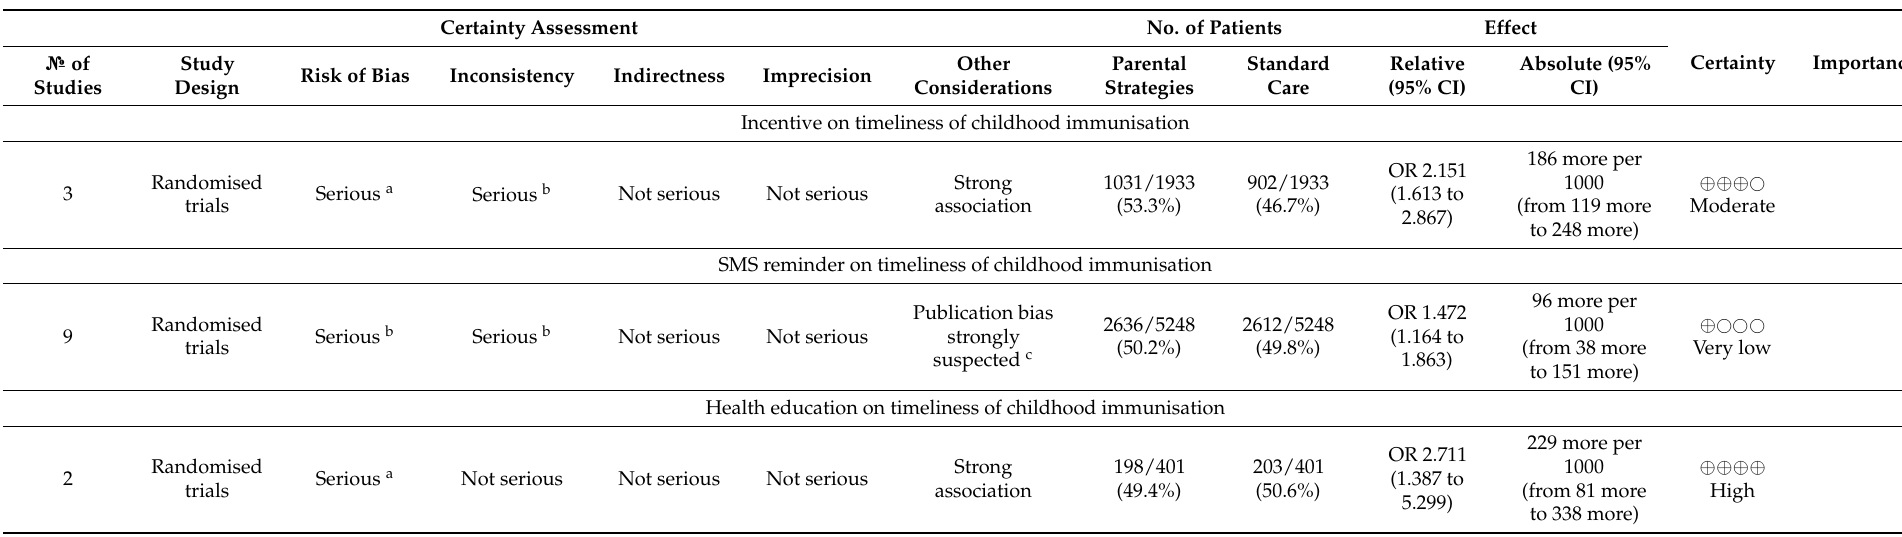
Table 5. Certainty of evidence for interventions on timeliness of childhood